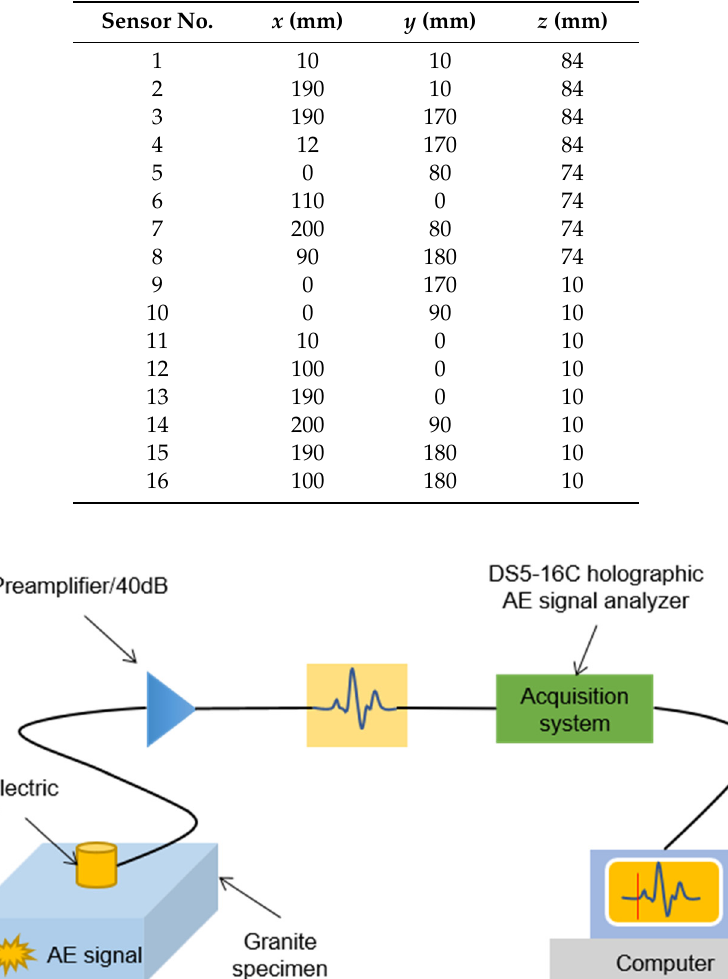
Table 1. The coordinates of 16 acoustic emission (AE) sensors used in the experiment of pencil lead breaks.